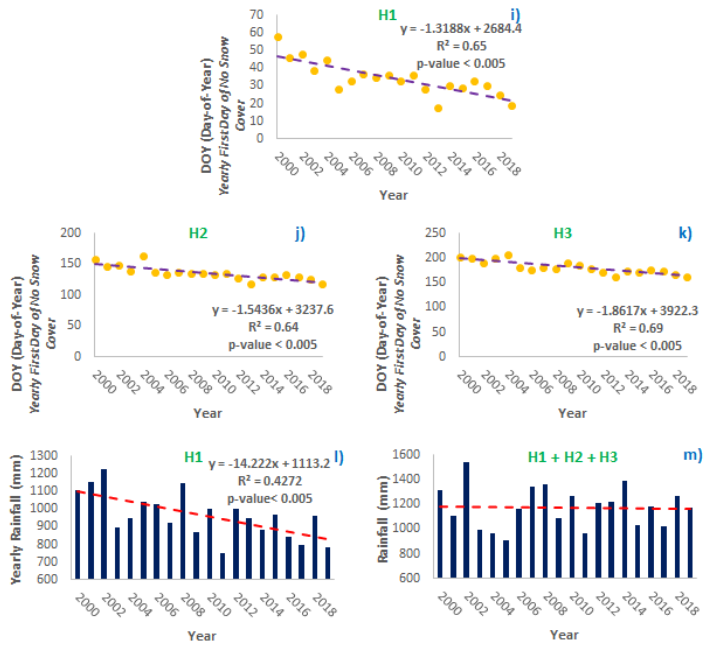
Figure 5. Yearly trends, respectively, of ( i , j , k ) annual first day of no snow cover (snow cover time) in height class (H1, H2 and H3) and ( l , m ) precipitation (rainfalls including snowfalls) in the height class (H1, and in the whole territory of Aosta Valley) in the period from 2000–2019. Finally, by analyzing snowpack persistence defined by the timing of the annual sea- sonal snowmelt that is calculated as the yearly first day of no snow cover (SC) in all the